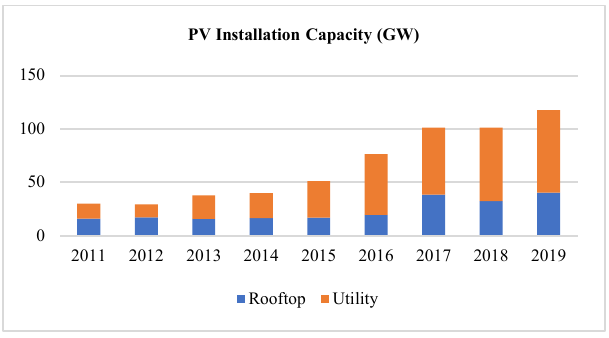
Figure 1. Global photovoltaic installed capacity during 2011–2019. Table 1. Comparison of different cloud height observation